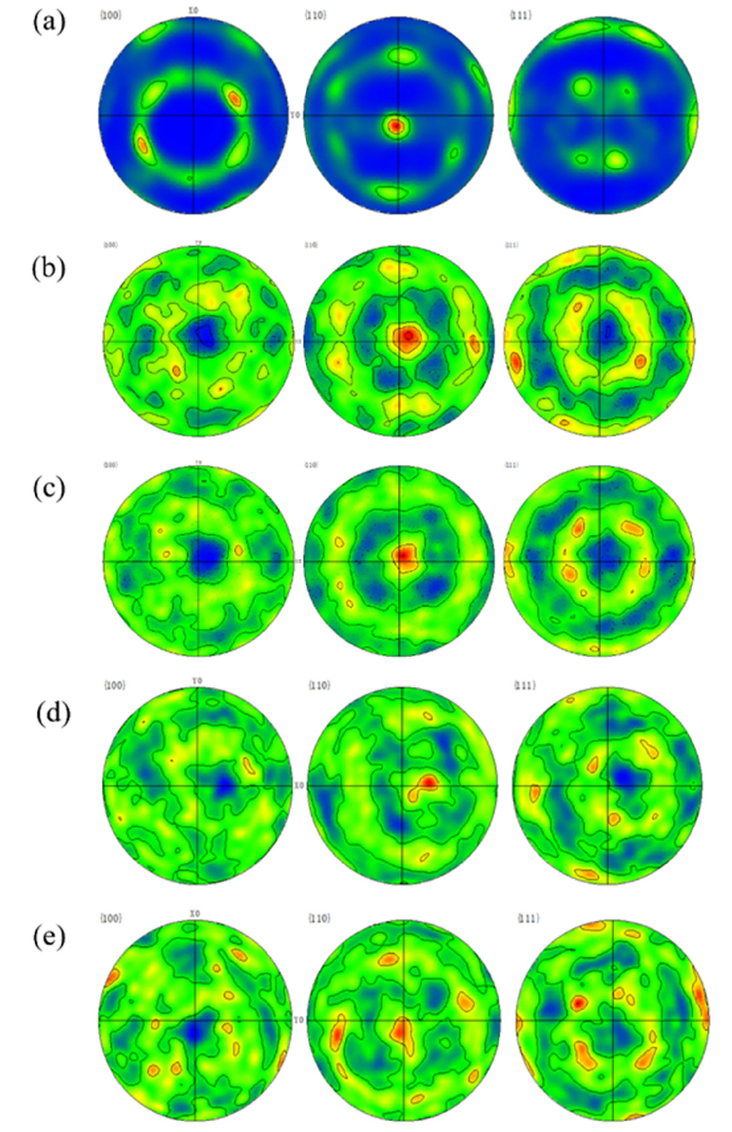
Figure 11. The pole figure (PF) of Ni-36.6W-15Co in ( a ) rolled, and after annealing for ( b ) 10 min, ( c ) 30 min, ( d ) 60 min and ( e ) 120 min at 1150 °C.